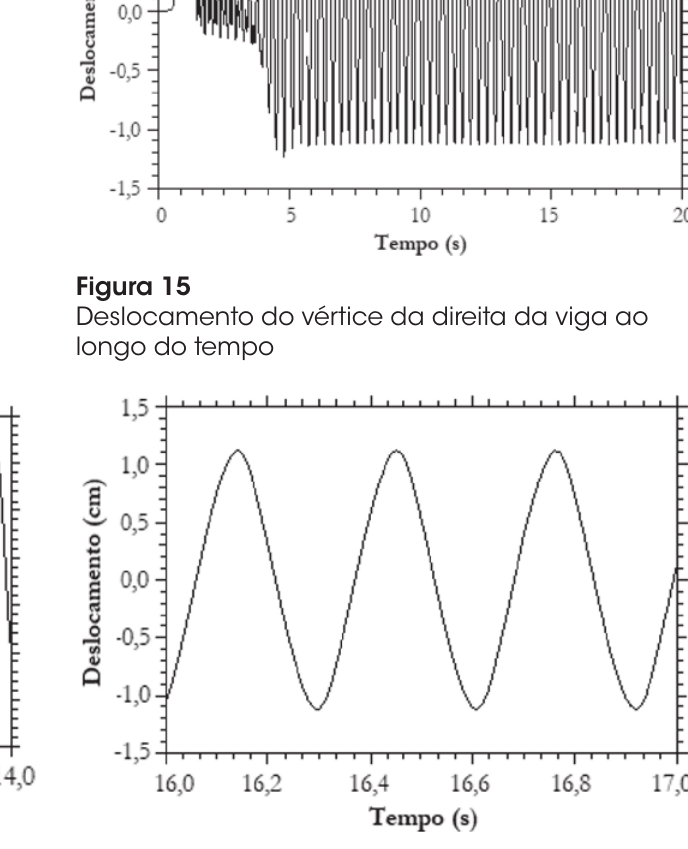
Figura 16 Deslocamento do vértice da direita da viga entre 16 e 17 segundos de